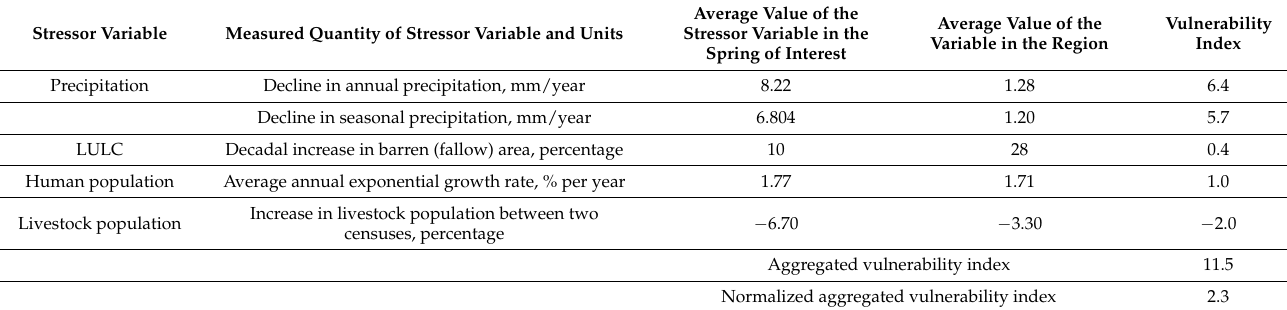
Table 6. Calculation of vulnerability index of Mathamali spring in Uttarakhand, India. Stressor